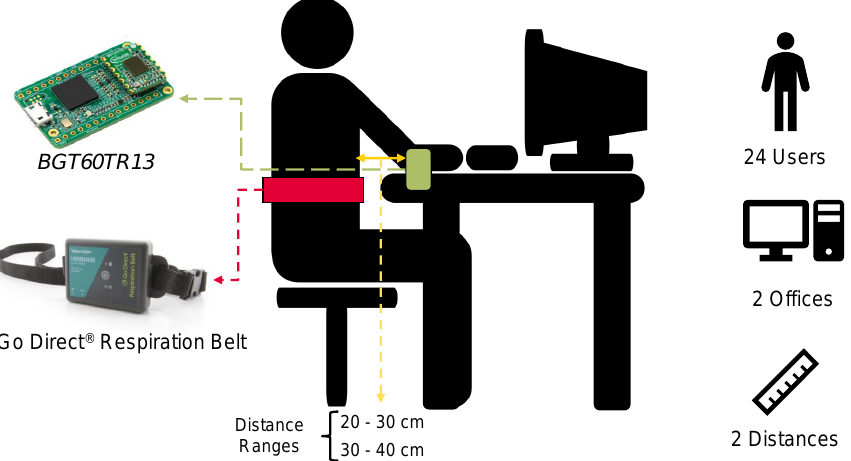
Figure 4. Recording Setup. A synchronized radar system and respiration belt are used to col- lect 10 30-second sessions per user and distance. The distance ranges used in data collection (up to 30 or 40 cm), refer to the distance between the chest and the radar